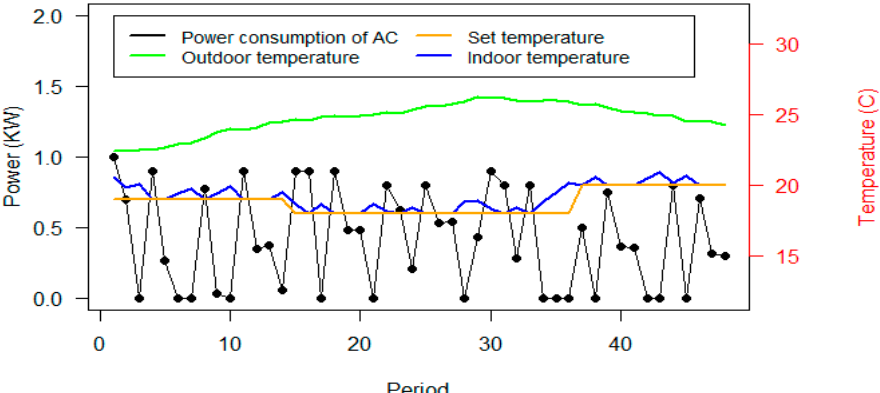
Figure 13. Power consumption of the AC and thermal parameters of Office #2, Day #13, in scenario B.